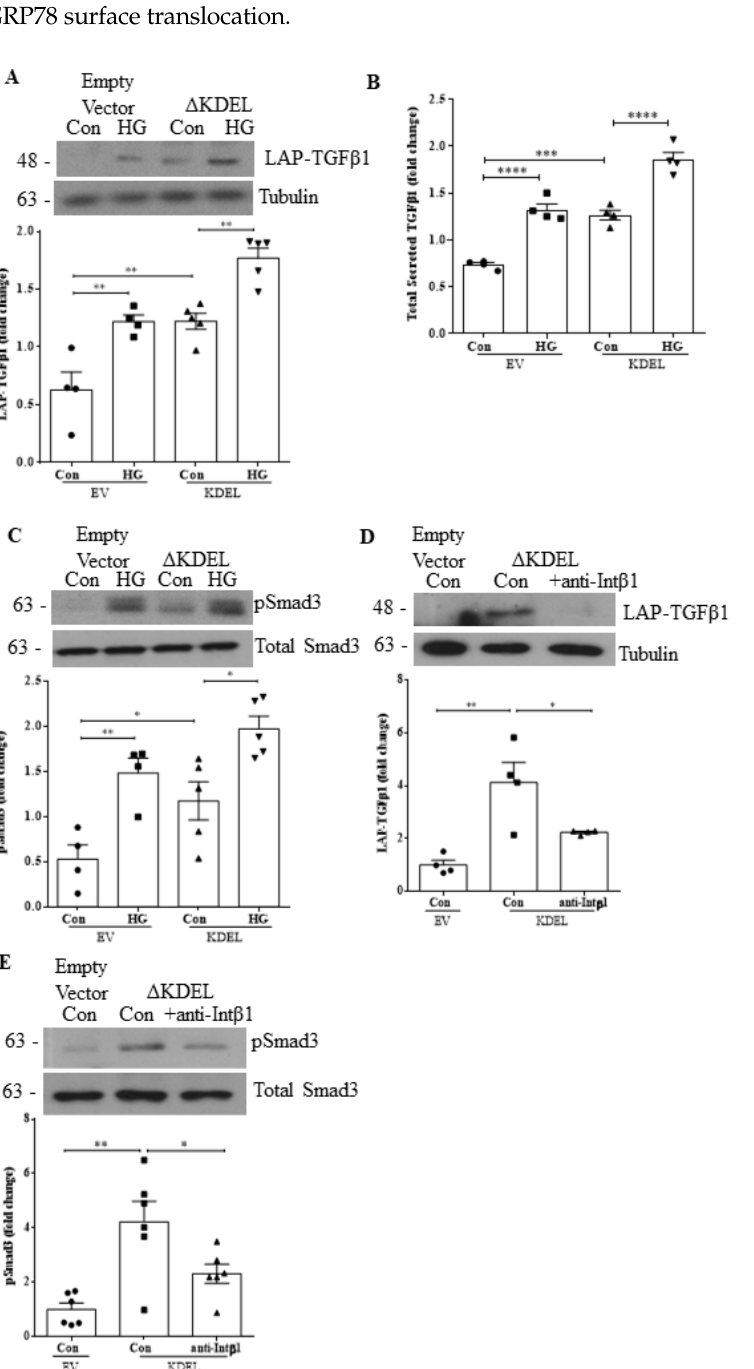
GRP78 surface translocation.